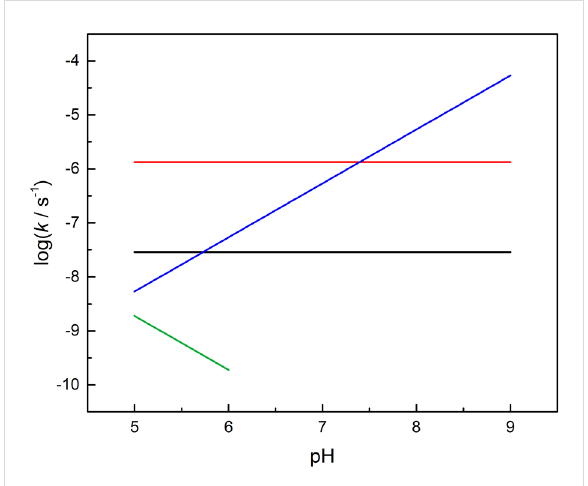
Figure 6: First-order rate constants for buffer-independent partial reac- tions of uridyl-3´,5´-uridine at pH 5–9 and 90 °C. Hydronium-ion-cata- lyzed isomerization (green), hydroxide-ion-catalyzed cleavage (blue), pH-independent cleavage (black), pH-independent isomerization (red). Based on the data from ref .